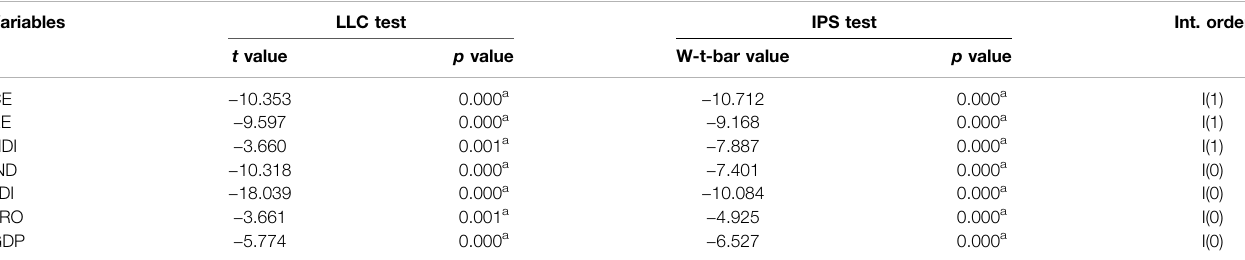
TABLE 6 | Test result of panel unit root-Low-income countries.